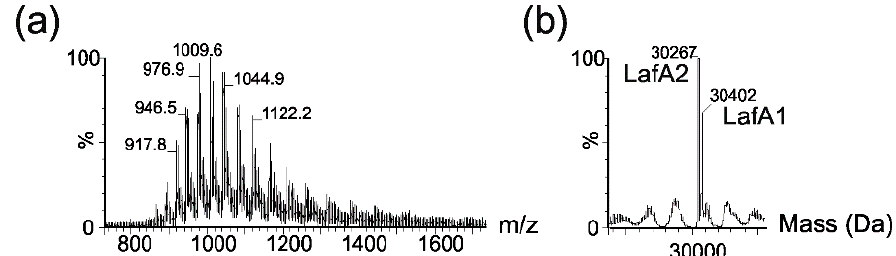
Figure 3. Electrospray mass spectrometry of intact lateral flagellin proteins from Aeromonas hydrophila AH-1. ( a ) Electrospray mass spectrum of intact lateral flagellin proteins showing a complex envelope of multiply charged protein ions; ( b ) The reconstructed molecular mass profile of the lateral flagellin resolves two masses at 30,267 and 30,402 Da, closely corresponding to the predicted mass of lateral flagellin proteins LafA1 and Laf A2.